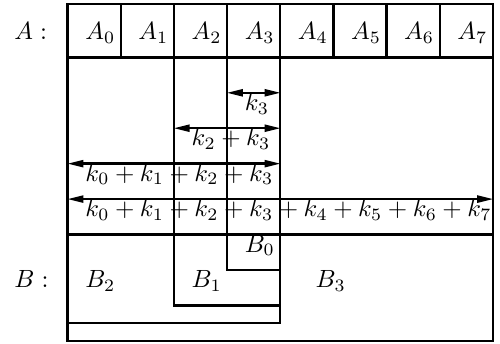
Figure 7. A schematic representation of Lemma